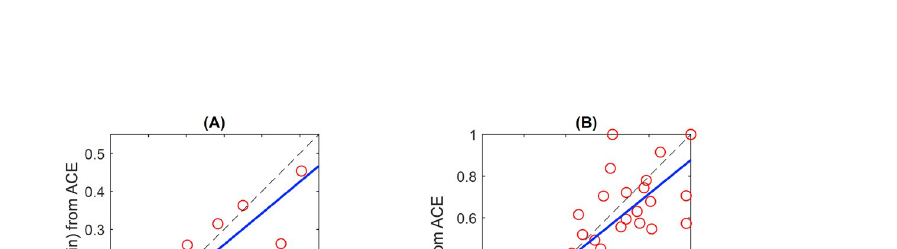
PLOS ONE | https://doi.org/10.1371/journal.pone.0234520 June 10,